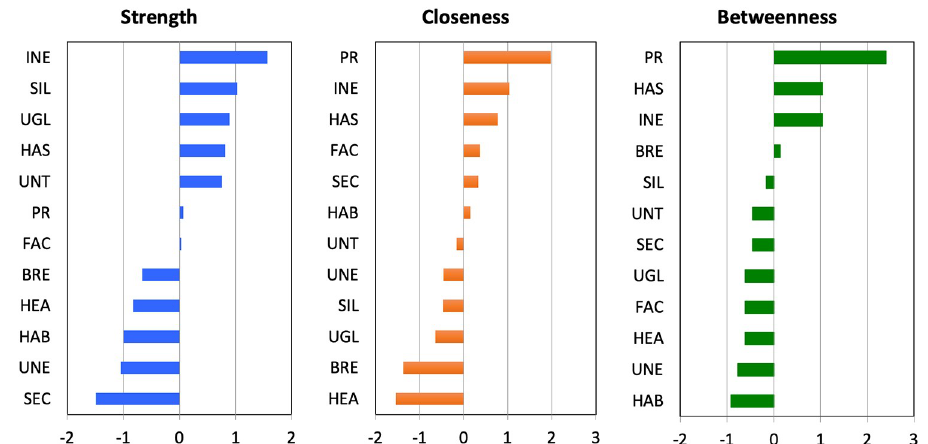
Fig 2. Centrality indices for nodes in the network analysis of anti-mask attitudes. Large values indicate that a given node had greater importance in the network, as indicated by its connections (edges) with other elements in the network. BRE : It is difficult to breathe when wearing a facemask. FAC : Facemasks are unsafe because they force you to touch your face. HAB : It is hard to develop the habit of wearing a facemask. HAS : Wearing a facemask is too much of a hassle. HEA : Facemasks cause me to overheat. INE : Facemasks are ineffective. PR : I do not like feeling forced to wear a facemask. SEC : Facemasks provide a false sense of security. SIL : Facemasks look silly. UGL : Facemasks look ugly or weird. UNE : Facemasks make other people feel uneasy. UNT : Facemasks make people look untrustworthy.